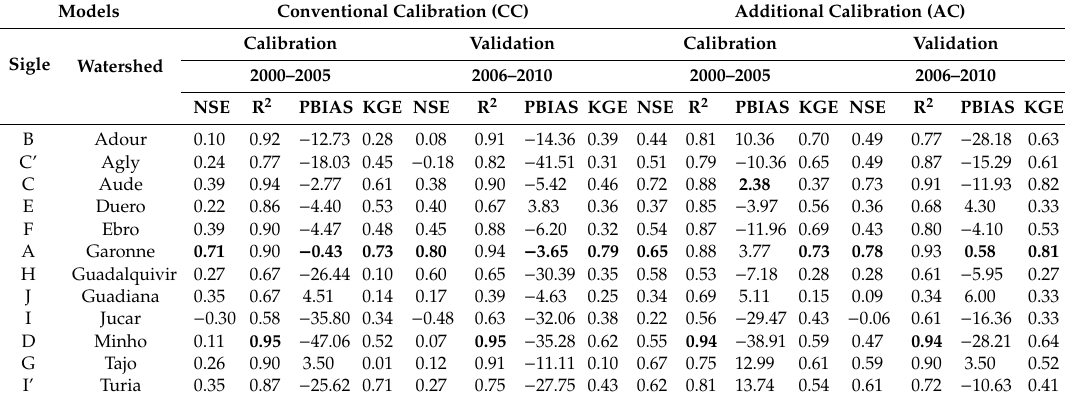
Table 3. Nash and Sutcli ff E ffi ciency (NSE), R 2 , percent bias (PBIAS), and Kling–Gupta e ffi ciency (KGE) performance of Soil and Water Assessment Tool (SWAT) models at watersheds’ outlets (cf. Figure 2 for station localization) for calibration (2000–2005) and validation period (2006–2010) on a monthly scale. Bold values indicate the best performances (CC: conventional calibration; AC: additional calibration). Conventional Calibration